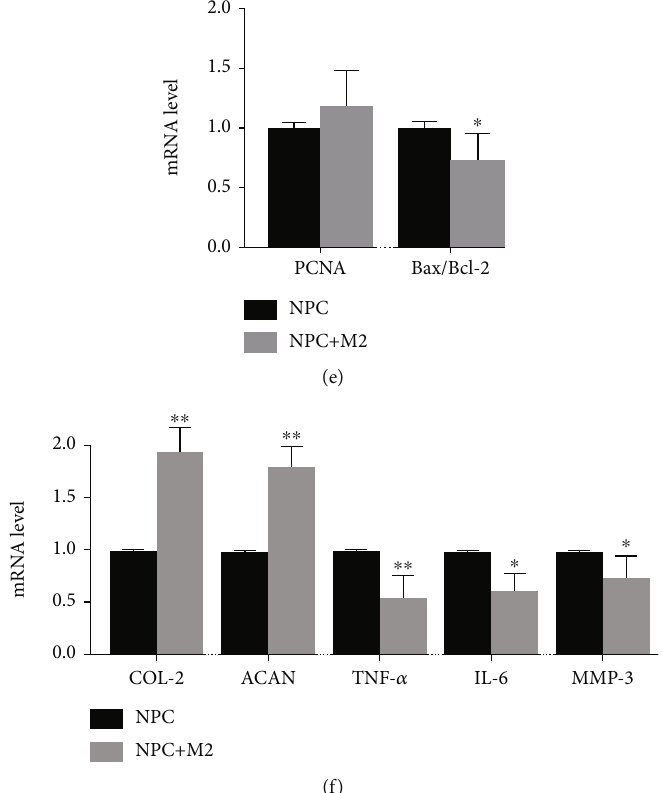
Figure 9: Coculture system of M2 macrophages and NPC was established. M2 macrophages reduced the apoptosis rate of NPC although did not reach a signi fi cant level as measured by TUNEL staining (a). However, the reduction of apoptosis rate reached the signi fi cant level in AO/EB staining assay (b) and fl ow cytometry (d). CCK-8 assay revealed that M2 macrophages signi fi cantly increased the NPC viability (c). Meanwhile, the expression level of PCNA gene increased, and the ratio of Bac/Bcl-2 genes decreased in NPC (e). Moreover, the expression level of COL-2 and ACAN signi fi cantly increased in NPC, while the expression level of TNF- α , IL-6, and MMP-3 signi fi cantly decreased in NPC (G). “ ∗∗∗ ” indicates p < 0 : 001 , “ ∗∗ ” indicates p < 0 : 01 . “ ∗ ” indicates p < 0 : 05 . RAW: RAW264.7 macrophages. NPC: nucleus pulposus